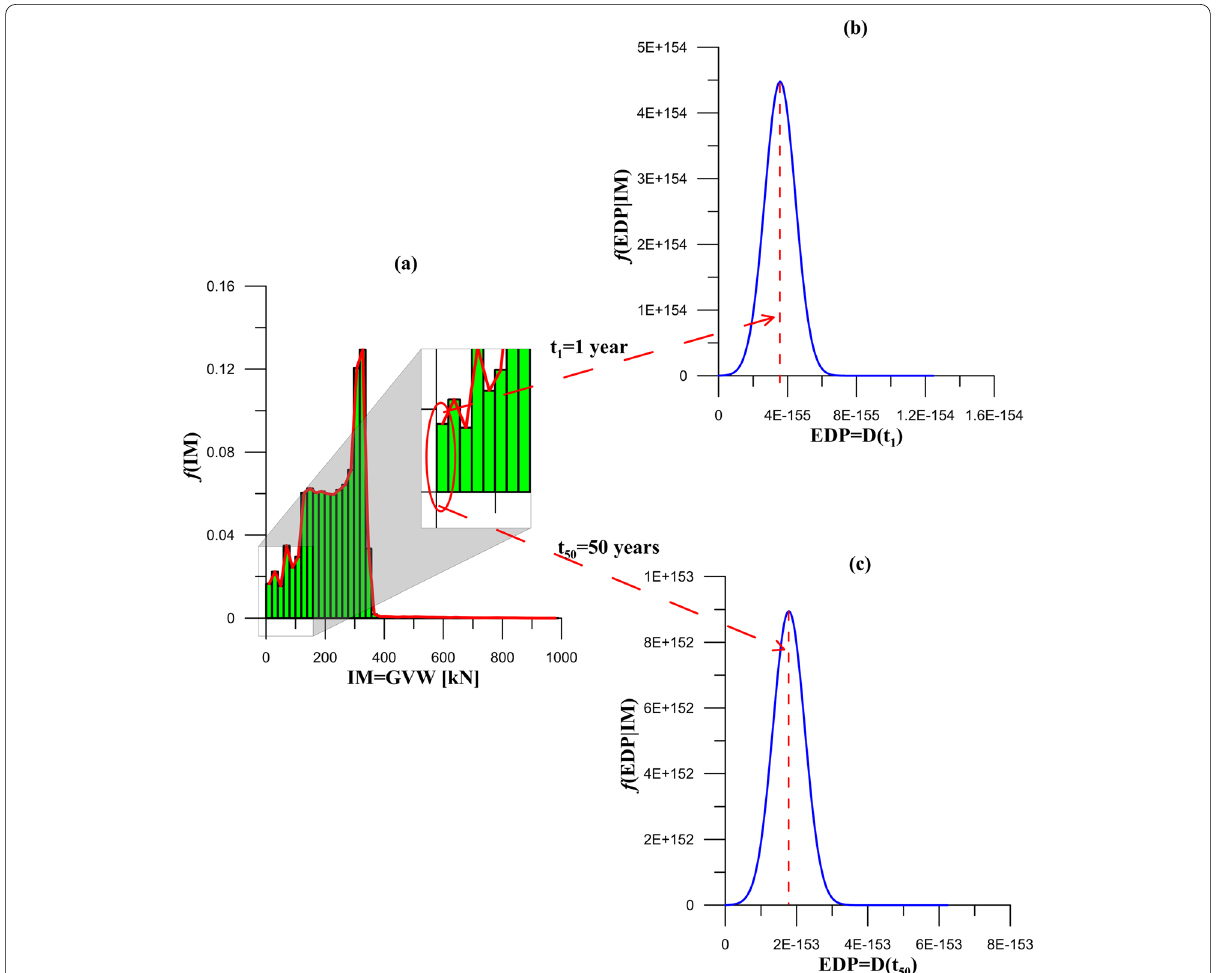
Fig. 4 Probability density function of IM (GVW) obtained from WIM data ( a ), probability density functions of EDP (D) for different operating years: t 1 1 year ( b ) and t 50 50 years ( c = =